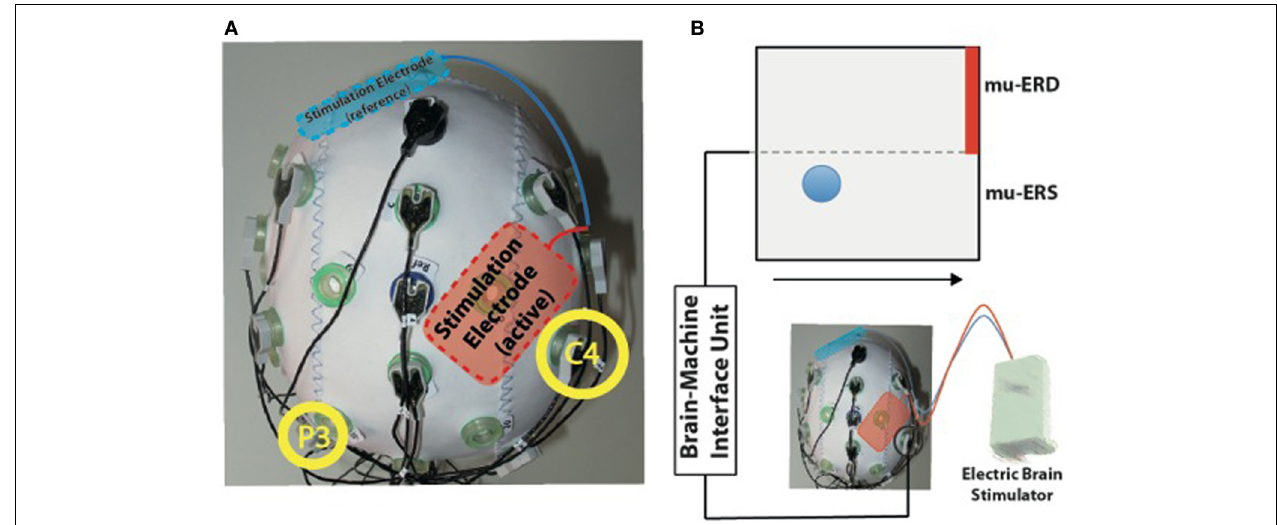
FIGURE 1 | (A) Experimental setup for simultaneous transcranial electric current stimulation during electroencephalography (EEG). The active stimulation electrode was placed immediately anterior to the EEG electrode C4 used for online brain-machine interface (BMI) control (right yellow circle). The reference stimulation electrode was placed over the left supraorbital region (blue). (B) BMI paradigm. Electric brain activity recorded